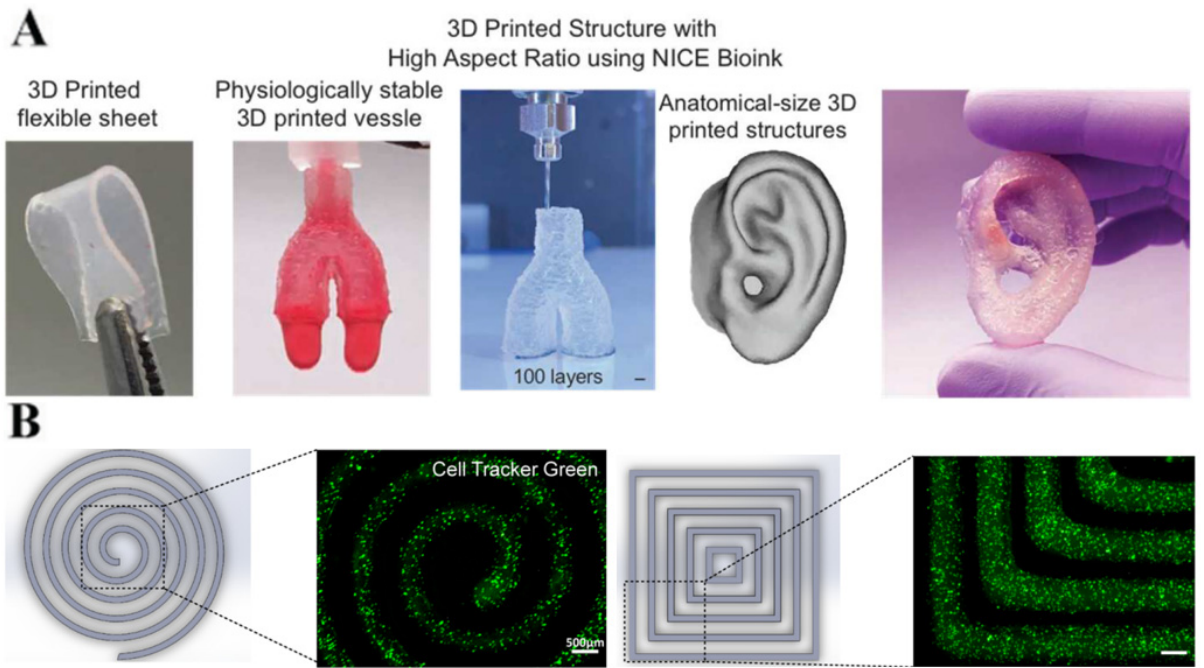
Figure 21. ( A ) Stable cross-linked 3D-printed structures from NICE bioinks able to support more than 50 times their own weight, have high aspect ratios and high structural fidelity (bifurcated vessels and physiological structures such as human ear). (Adapted with permission from [131].